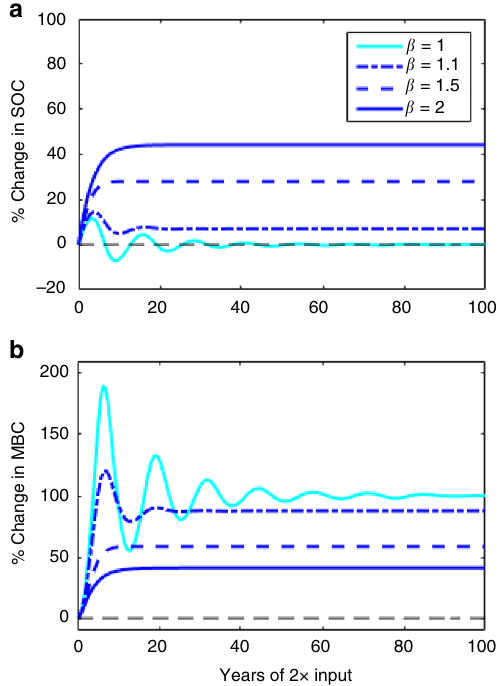
Fig. 3 Response of SOC and MBC to a sustained doubling of C inputs in the two-pool microbial model with and without density-dependent microbial turnover. a Percent change of modeled SOC following a 2× step increase in total C inputs. b Percent change of modeled MBC following a 2× step increase in total C inputs. The value of the parameter β depicts the strength of density-dependent microbial turnover, where β = 1 corresponds to no density-dependence and β = 2 to a strong density-dependence